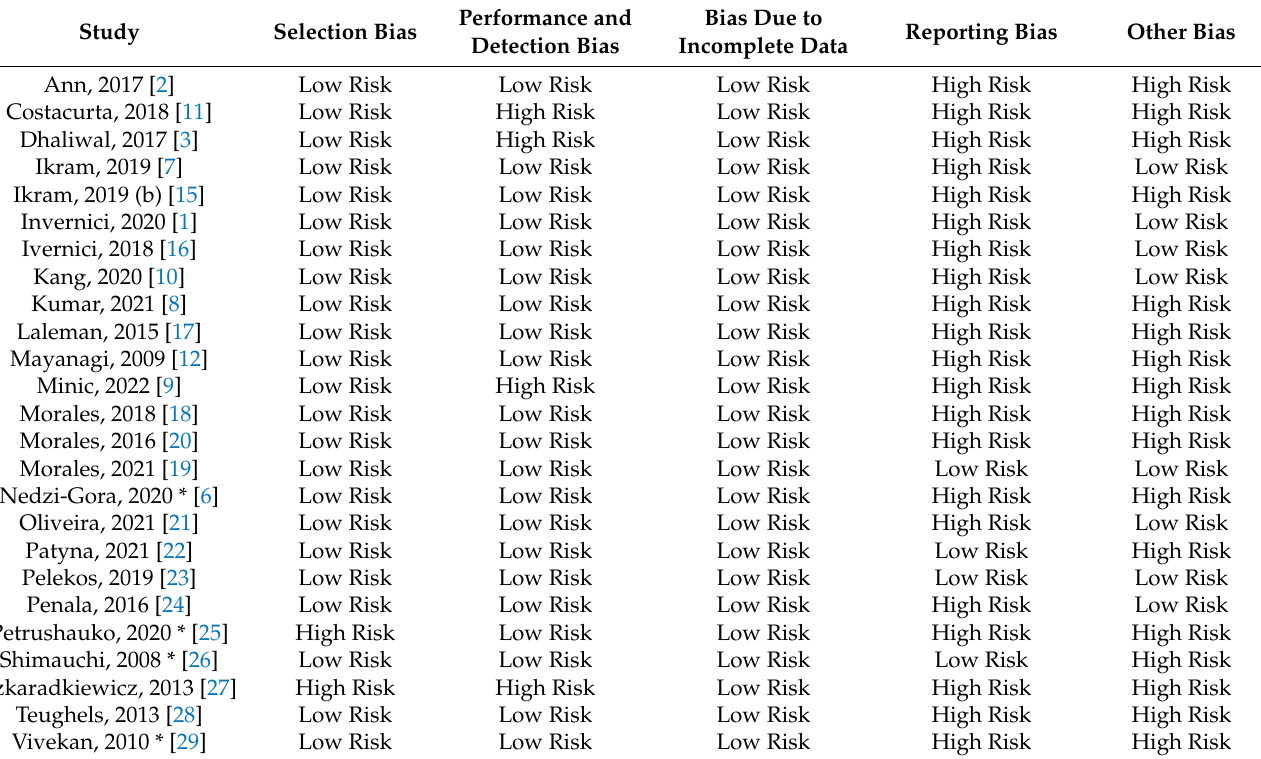
Table 3. Qualitative synthesis for clinical trials. (*: articles excluded from the